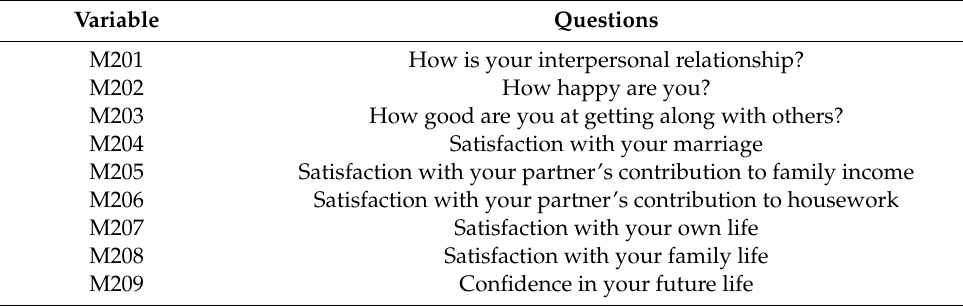
Table 2. Indicators of parents’ life